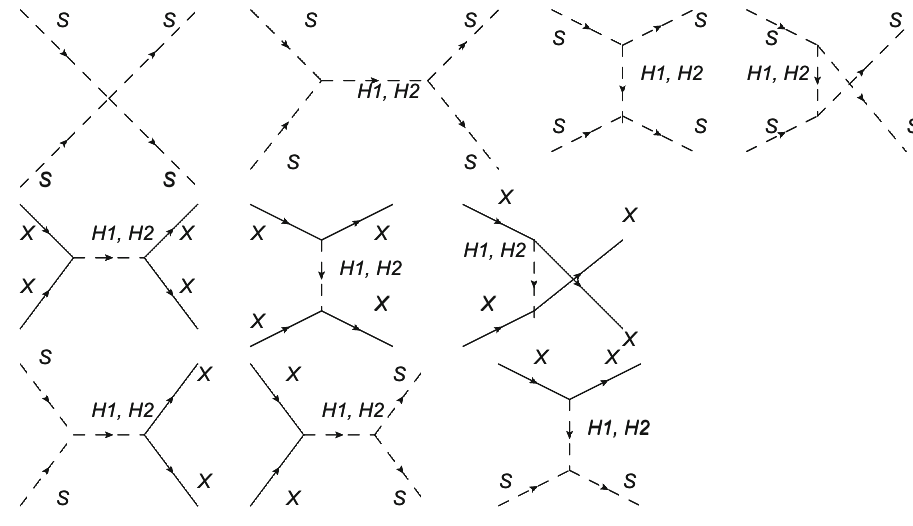
Fig. 9 The Feynman diagrams for scalar and fermion DM